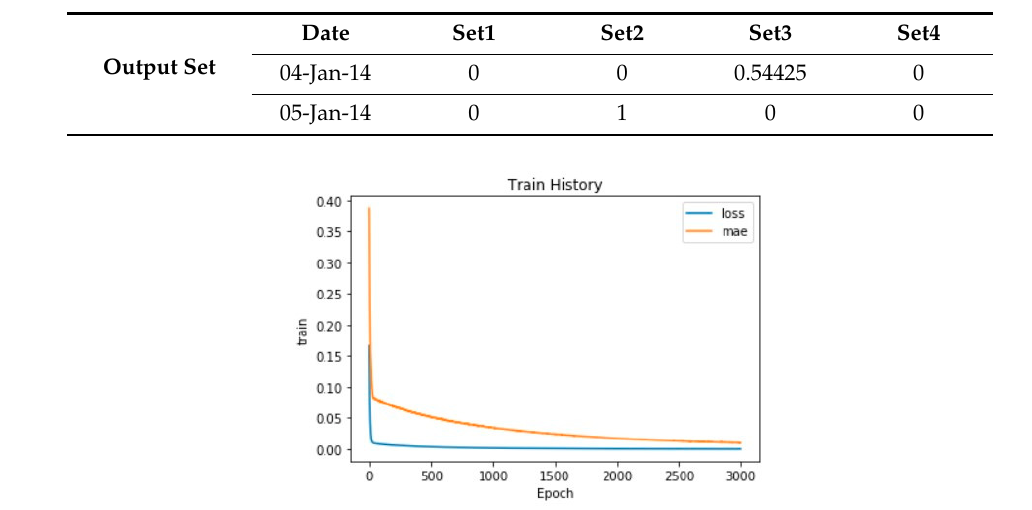
Figure 16. 04-Jan-2014 The training process of RNN.